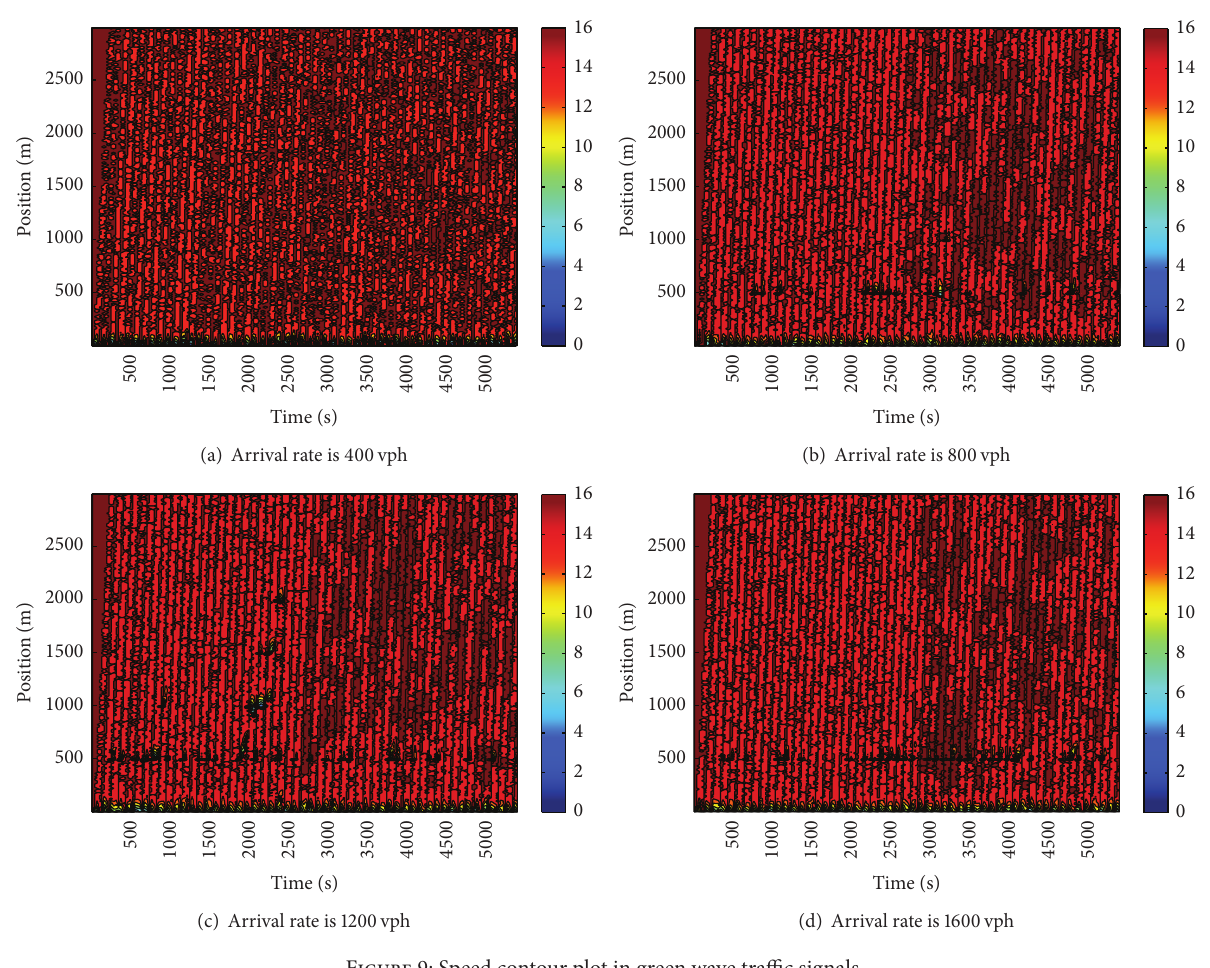
Figure 9: Speed contour plot in green wave traffic signals.